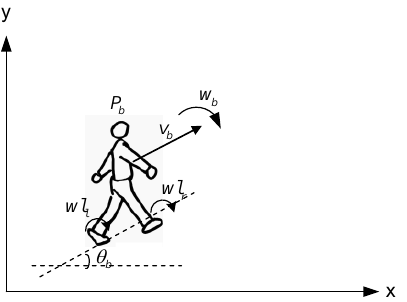
Fig. 2. Model of walking person in the coordinate system